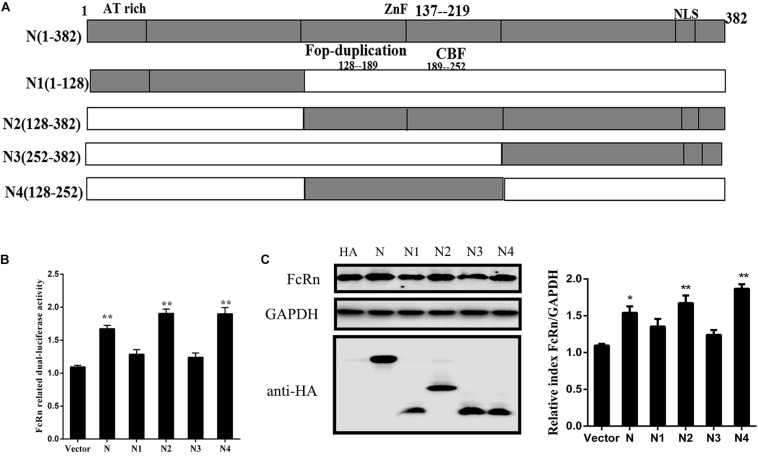
Schematic representation of the TGEV N-protein serial-deletion mutant constructs. (A) Schematic representation of the TGEV N-protein serial-deletion mutant constructs. (B) IPEC-J2 cells were co-transfected with pRL-TK, FcRn-Luc, and TGEV N deletion-mutant expression plasmids. The cell lysates were harvested for dual luciferase assays at 24 hpi. (C) IPEC-J2 cells were co-transfected with TGEV N deletion-mutant expression plasmids for 36 h and protein expression in cell lysates was measured by Western blot using anti-HA antibody and anti-FcRn antibody. The right panel represents the quantification of the bands by densitometry, corrected by the amount of GAPDH. ∗p < 0.05, ∗∗p < 0.01.